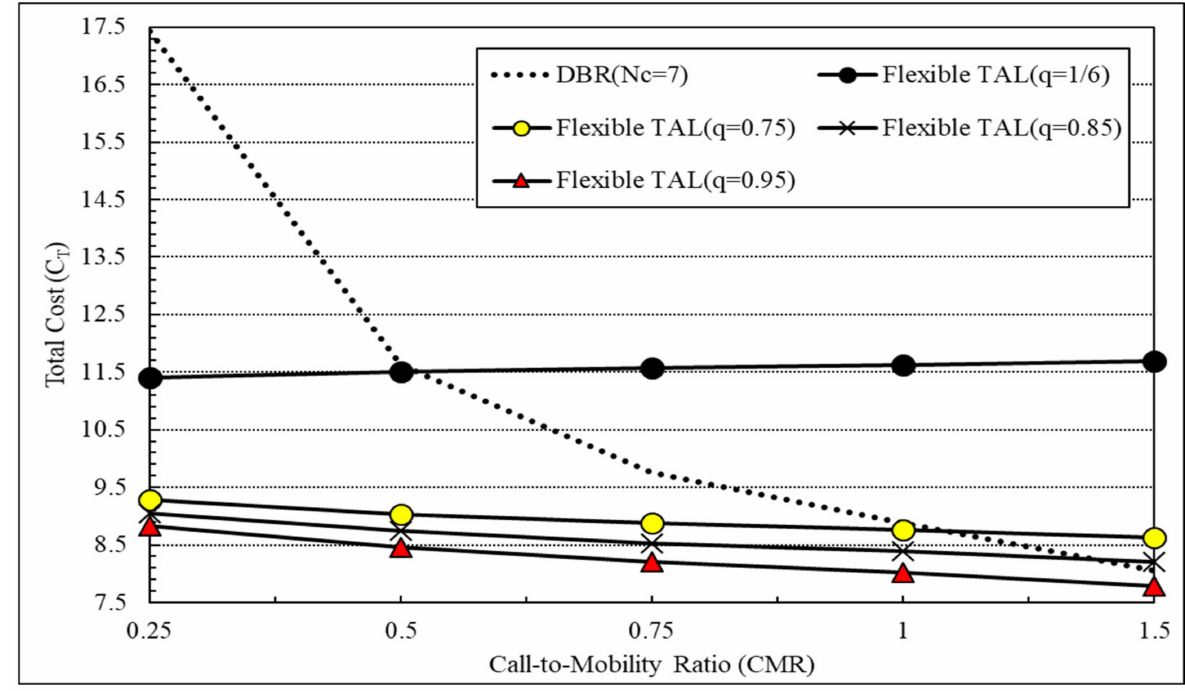
Figure 6. Total cost versus CMR and q (urban